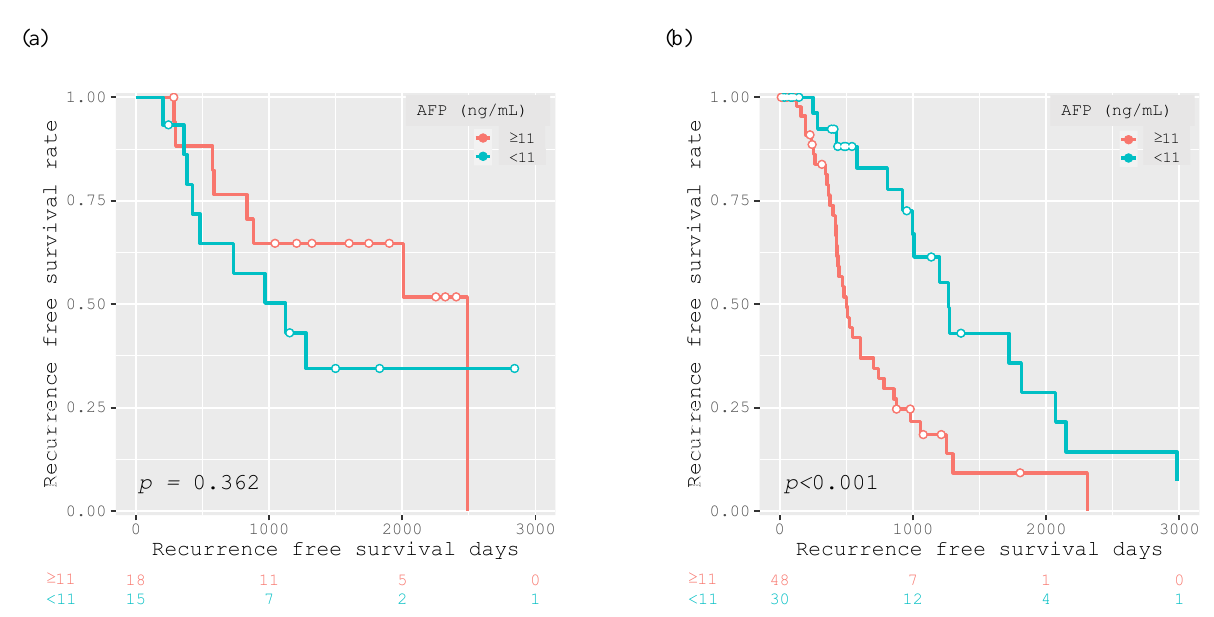
Among the patients who achieved SVR, there was no significant difference in the RFS rate between patients with AFP levels ≥11 ng/mL and <11 ng/mL ( p = 0.362; Figure 5a). On the other hand, among the p atients who did not achieve SVR, those with AFP levels ≥11 ng/mL had significantly poorer RFS than those with AFP levels <11 ng/mL ( p < 0.001; Fig- ure 5b).